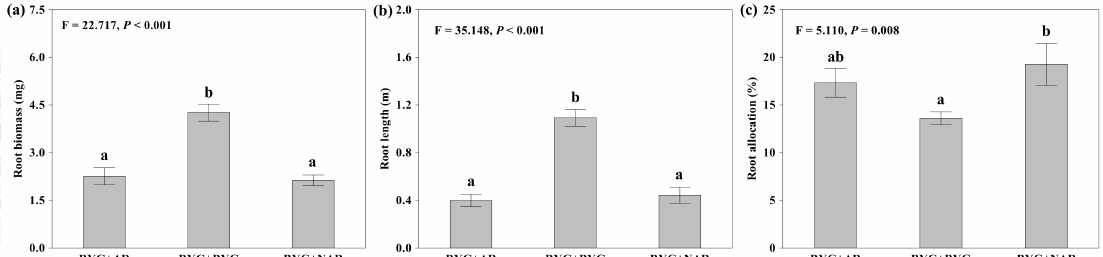
Figure 1. Root biomass ( a ), root length ( b ) and root allocation ( c ) of barnyardgrass grown as a monoculture (BYG + BYG), as mixed cultures with allelopathic rice (BYG + AR) and nonallelopathic rice (BYG + NAR). Each value is the mean ± SE. Bars with different letters are significantly different at the p < 0.05 level according to Tukey’s test.